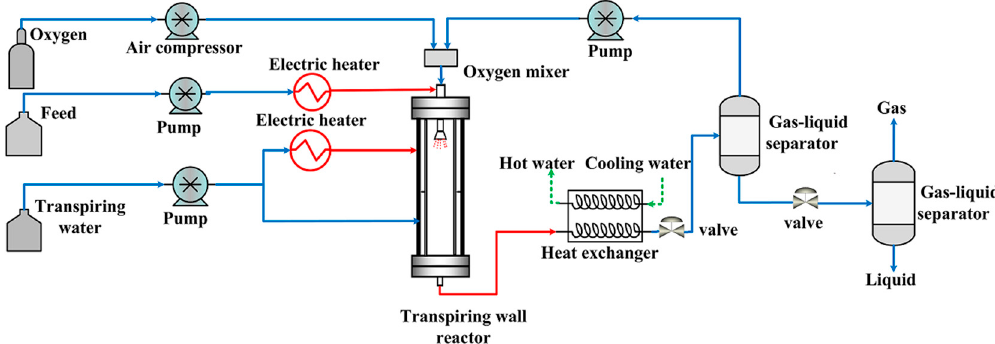
Figure 3. The simplified diagram of a SCWO system to increase the oxygen utilization rate.